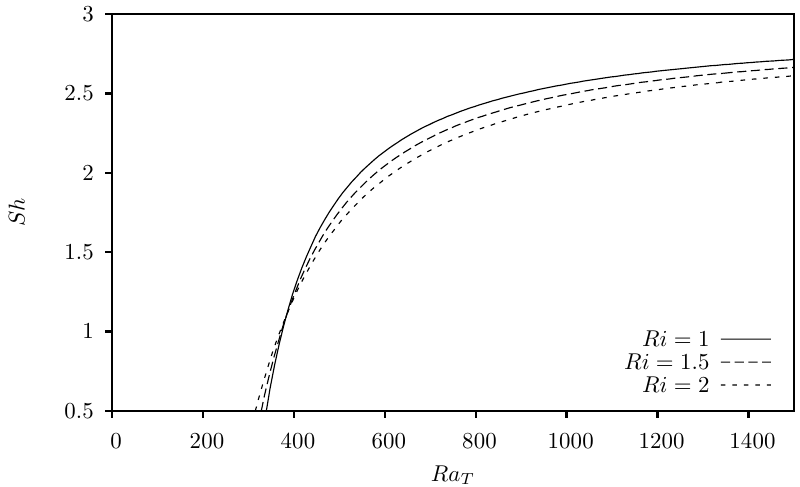
Figure 15. Variation of Sh with Ra T for steady nonlinear stability: effect of R i for Ras = 250, Du = 0.05, Sr = 0.005, Le =